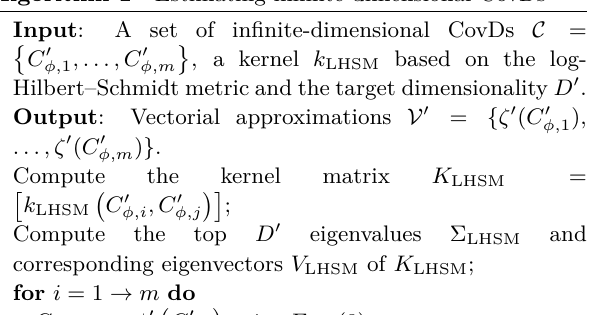
Algorithm 1 Estimating infinite-dimensional CovDs